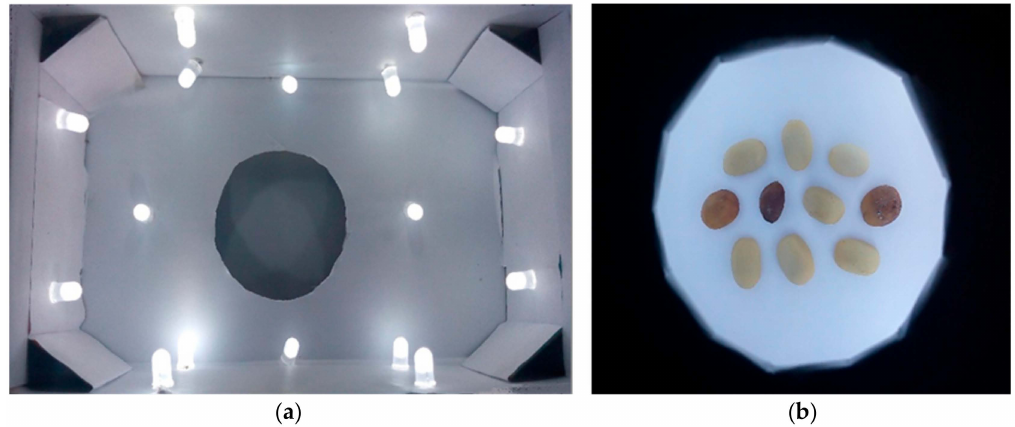
Figure 4. Image acquisition system: ( a ) bottom view and ( b ) top view.